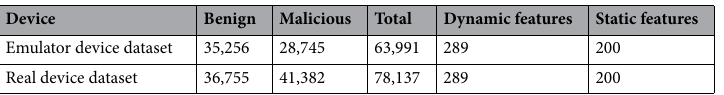
Table 2. Dataset detail.